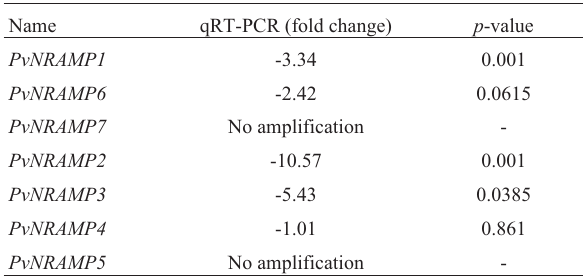
Table 3 - Quantitative RT-PCR for PvNRAMPs in C. lindemuthianum- in- fected leaves.